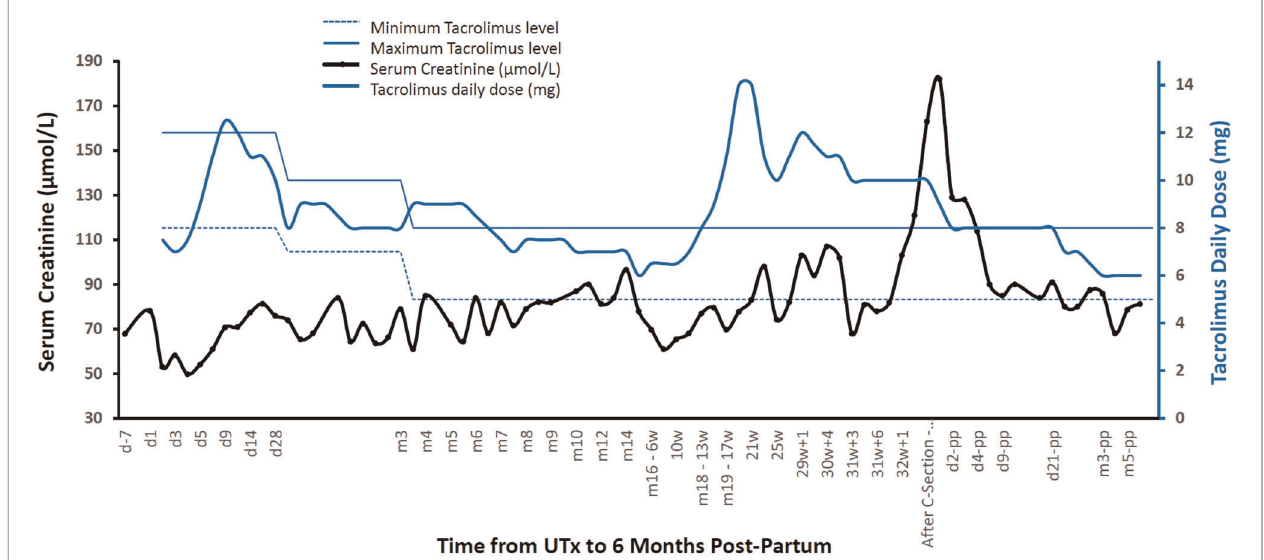
FIGURE 2 | Creatinine and tacrolimus concentrations from the day before UTx until day 6 post-partum. d: day; m: month; w: week of gestation; pp: post-partum. Blue lines represent objective levels ofresidual tacrolimus level (8 – 12 ng/mL duringthe fi rst month, 7 – 10 ng/mLduring the second andthird month,andthen 5 – 8 ng/mL).